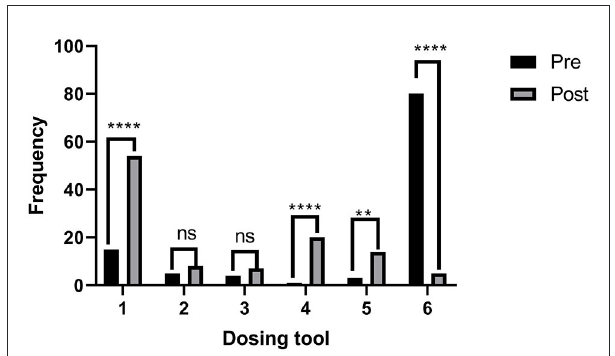
FIGURE6 Comparison of pre- and post-intervention responses of the survey participants showing a shift of preference from household spoon to medicine spoon. ** means very significant. **** means very highly significant.